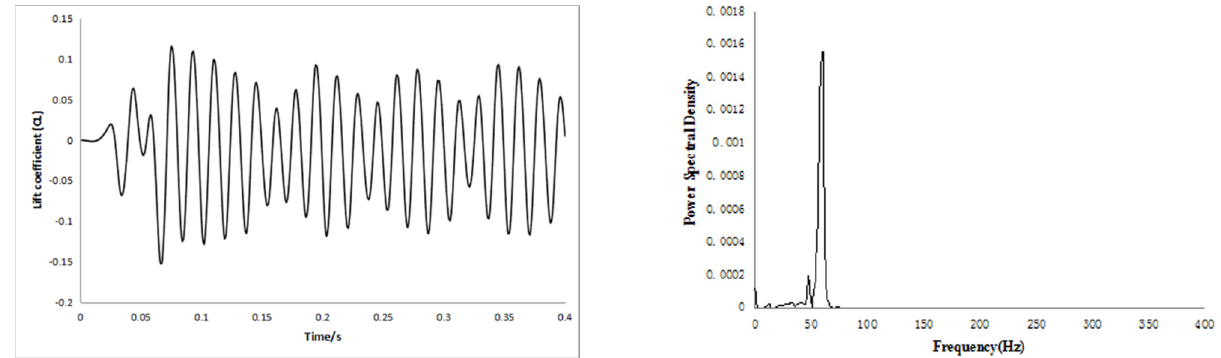
Figure 5. The lift coefficient time history curve and power spectrum curve of the vibration area under the 110% operation mode.